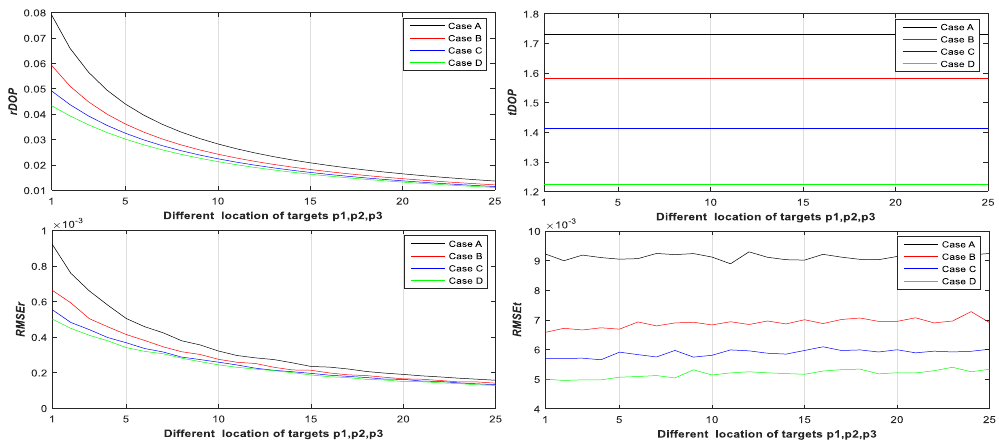
Figure 4. 2 rDOP , 2 tDOP , ,2 r RMSE , and ,2 t RMSE of Case A, B, C, and D with respect to two different targets.